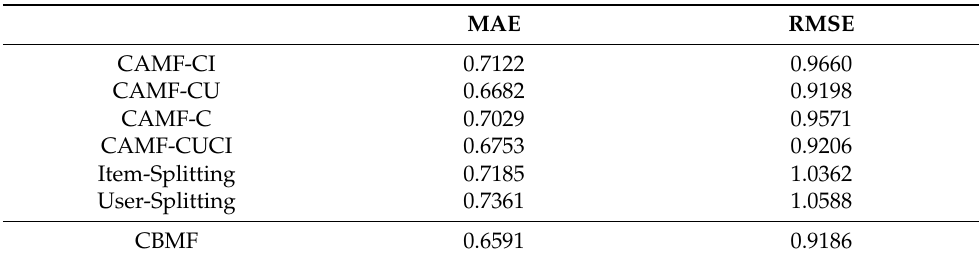
Table 12. Comparison between the proposed approach and other CARS techniques on De Paul Movie